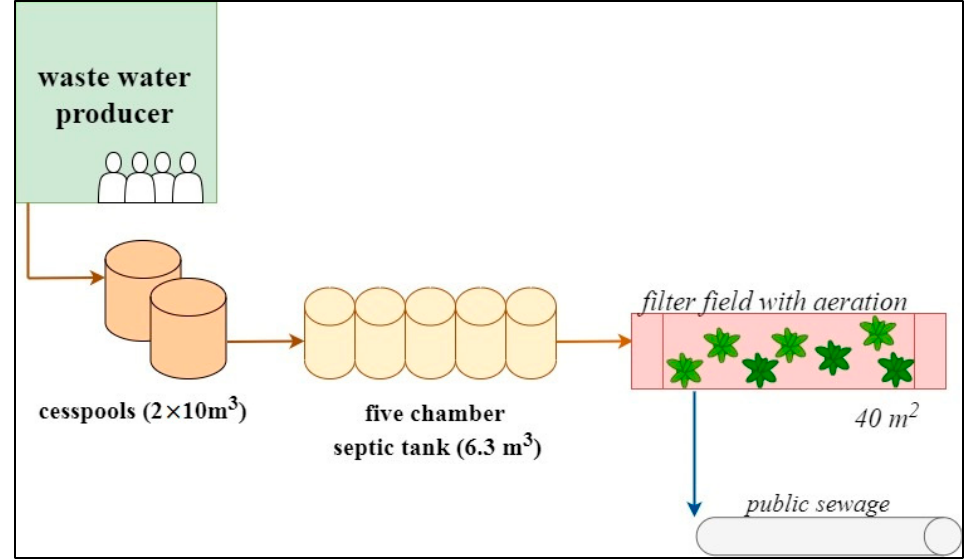
Figure 3. The scheme root WWTP type ECOair (according to the project documentation of ECOPLANET SLOVAKIA, s.r.o.; [19]).